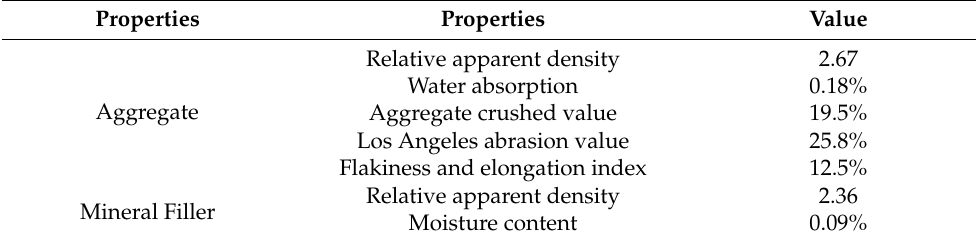
Table 2. Aggregate and mineral filler properties.